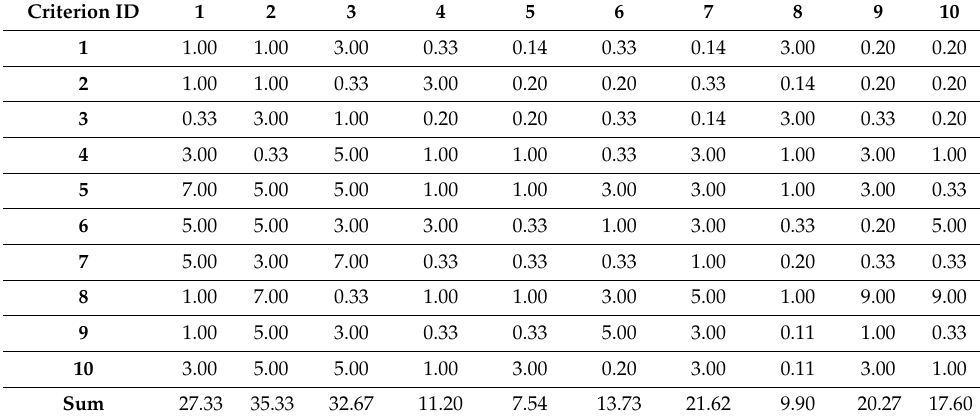
Table 4. Pairwise comparison matrix for the main criteria.